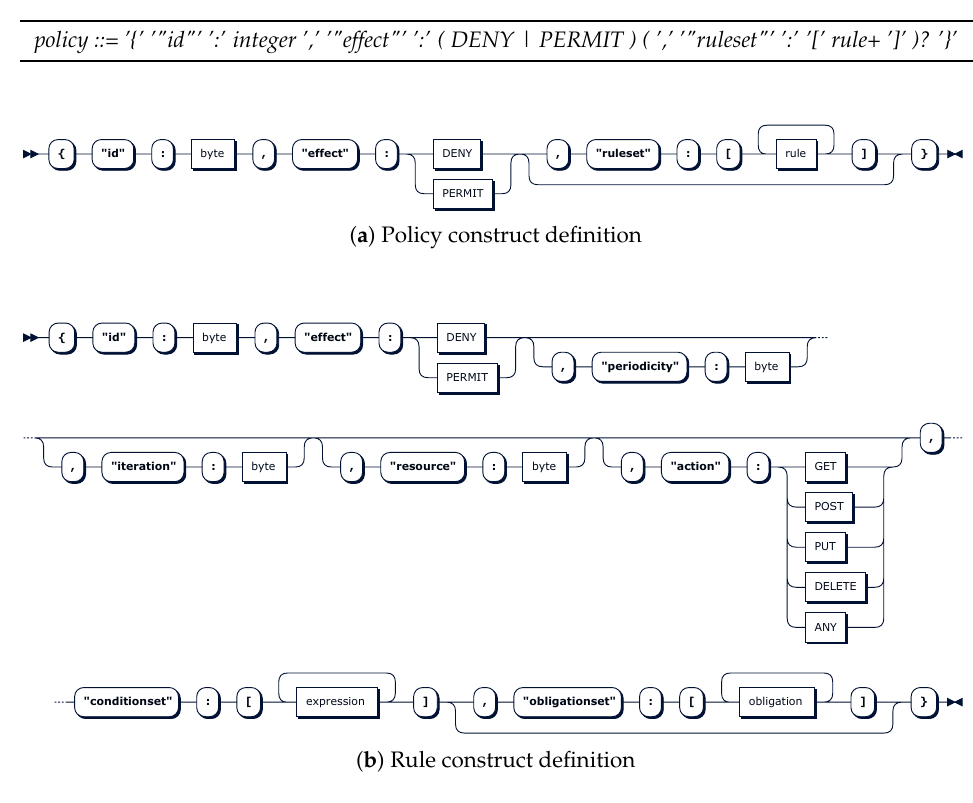
Table 1. EBNF representation of a schematic policy.